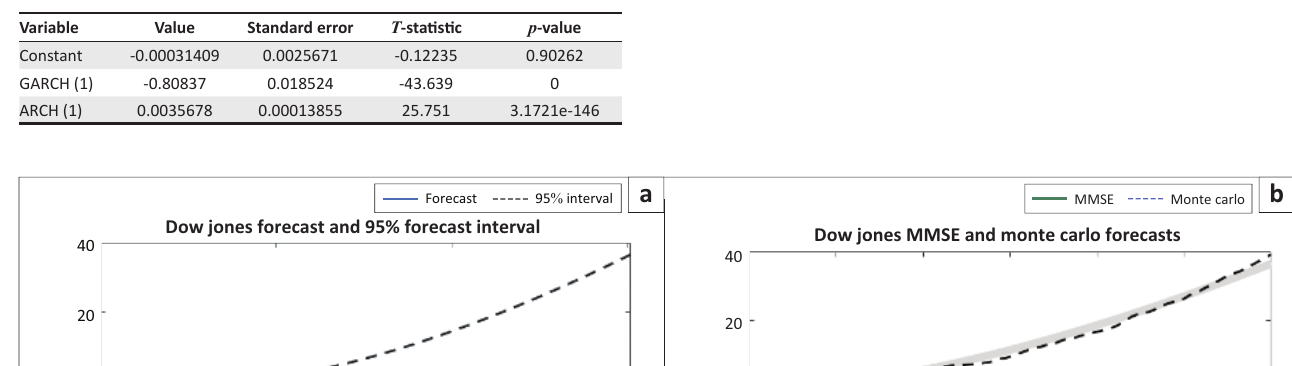
2. Modelling the Dow Jones estimating autoregressive integrated moving average and generalised autoregressive conditional heteroscedasticity for the best possible fit of the respective models.